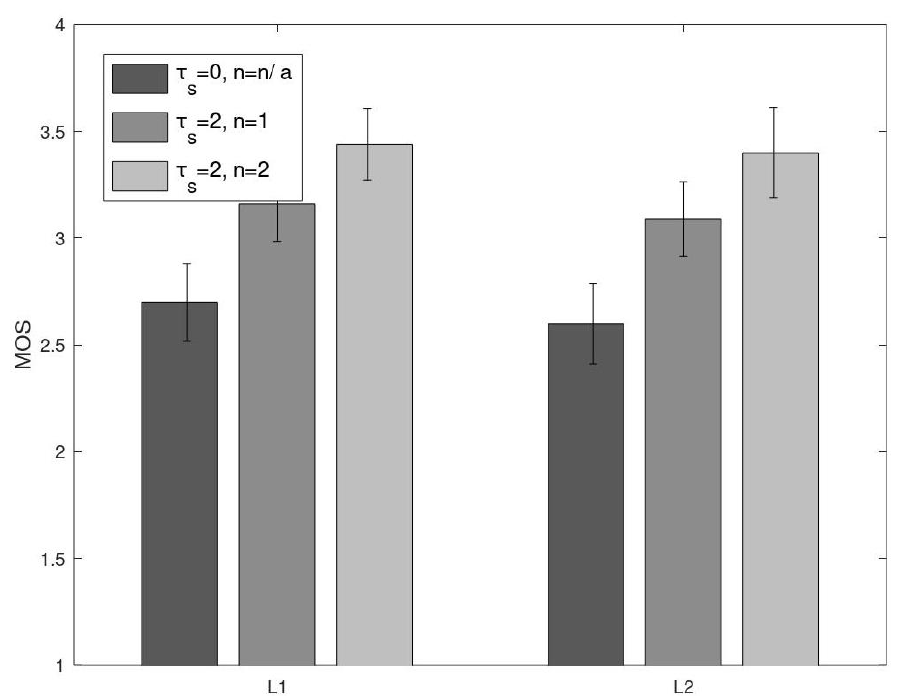
Figure 9. MOS with 95% confidence intervals of the “News” video with two outage locations for τ j = 1 and τ o =